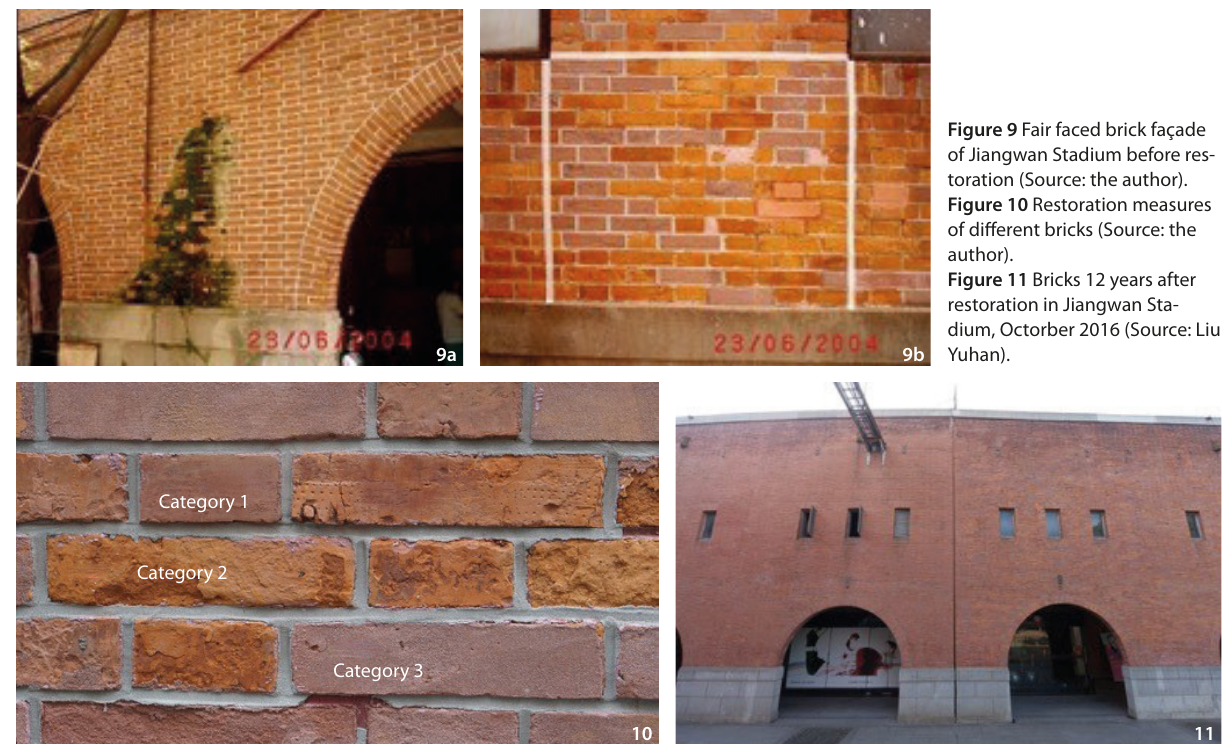
Figure 9 Fair faced brick façade of Jiangwan Stadium before res- toration (Source: the author). Figure 10 Restoration measures of different bricks (Source: the author). Figure 11 Bricks 12 years after restoration in Jiangwan Sta- dium, Octorber 2016 (Source: Liu Yuhan).